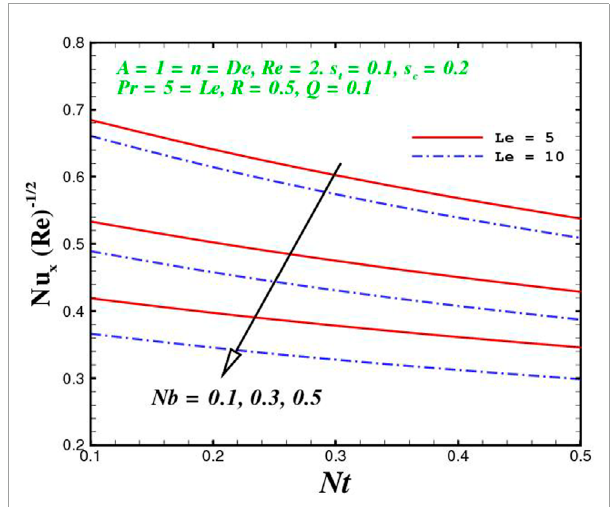
FIGURE 14 skinC f √ Re x , sketch for frequent values M and A.